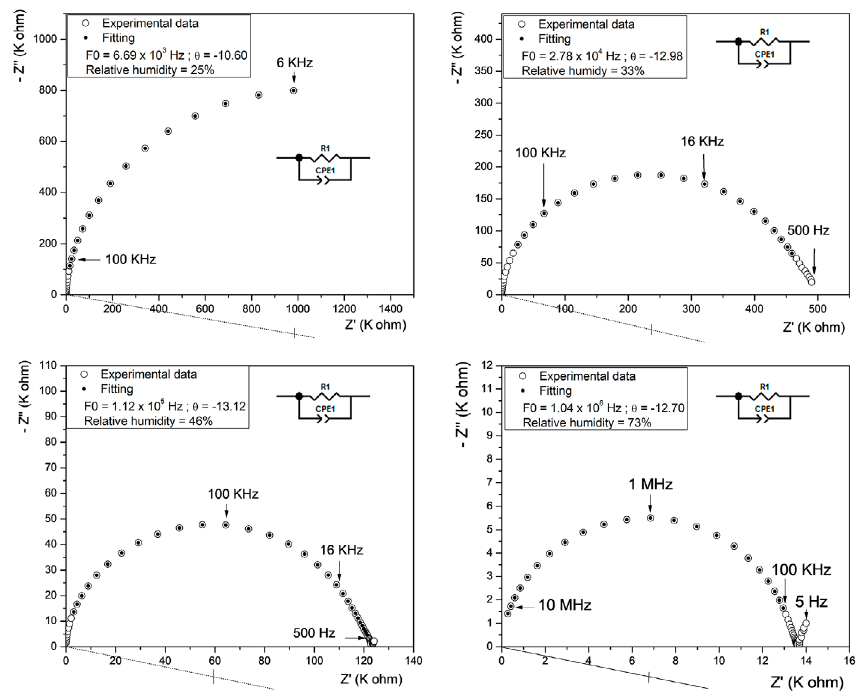
Figure 11. Equivalent circuits and Nyquist plots at room temperature of composition C sintered at 1350ºC with varying relative